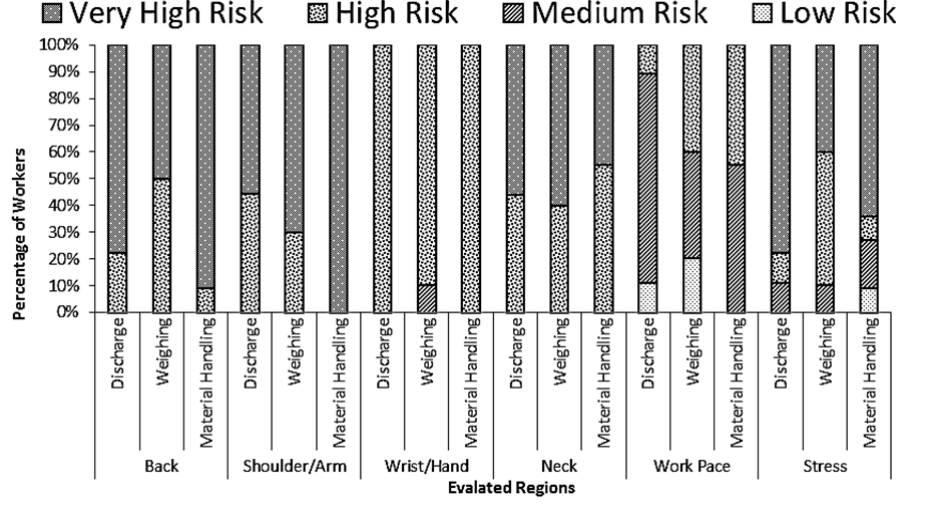
Figure 3. Distribution of the severity of the exposure to WMSDs across different operations in small-scale feed mills (from QEC